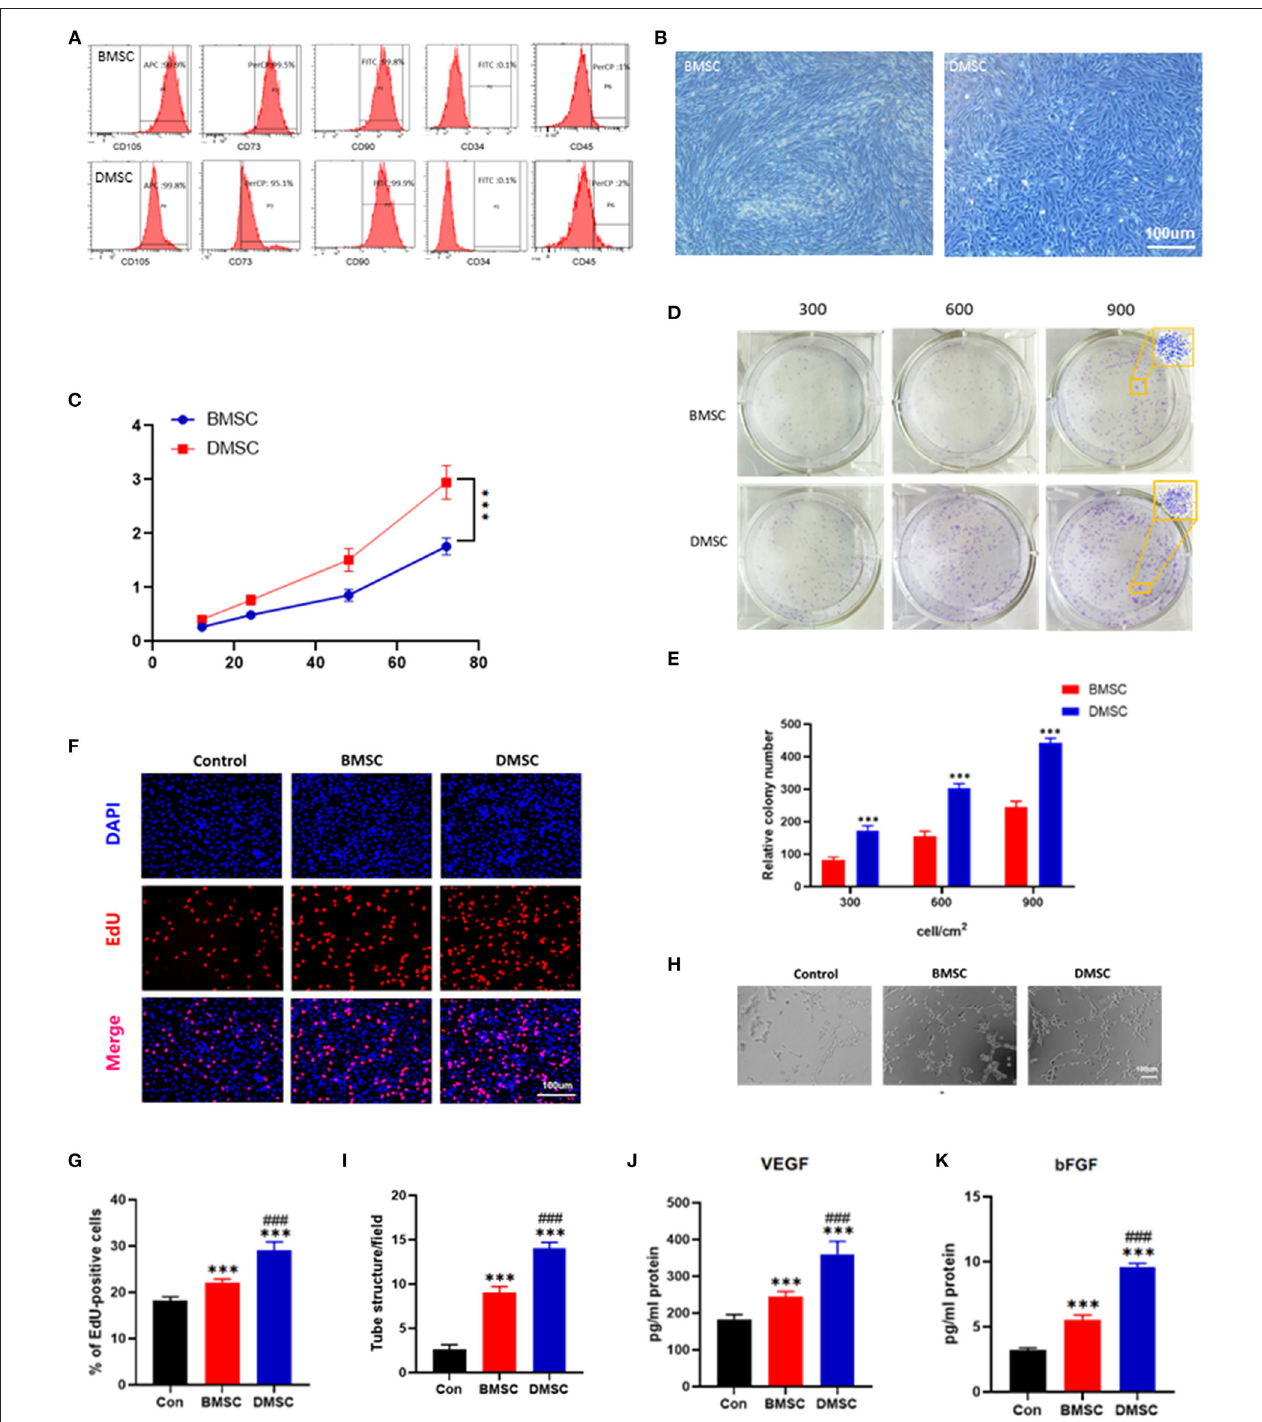
FIGURE 1 | Identification of DMSCs and BMSCs and comparison of their ability to promote proliferation and vascularization in vitro . (A) Flow cytometric analysis of cell surface markers on BMSCs and DMSCs. (B) Morphological observation of BMSCs and DMSCs. (C) Cell viability of BMSCs and DMSCs. (D,E) Morphological and quantitative analysis of representative colonies derived from BMSCs and DMSCs. (F) The proliferation ability of HUVECs in response to different treatments in vitro as assessed by EdU staining. (G) Quantitative analysis of EdU-positive cells. (H) Representative images of tube formation of HUVECs with different treatments in vitro . (I) Quantitative analysis of tube formation. (J,K) Detection of VEGF and bFGF secretion levels from HUVECs under different treatment conditions in vitro . * P < 0.05, ** P < 0.01, *** P < 0.001. # P < 0.05, ## P < 0.01, ### P < 0.001.